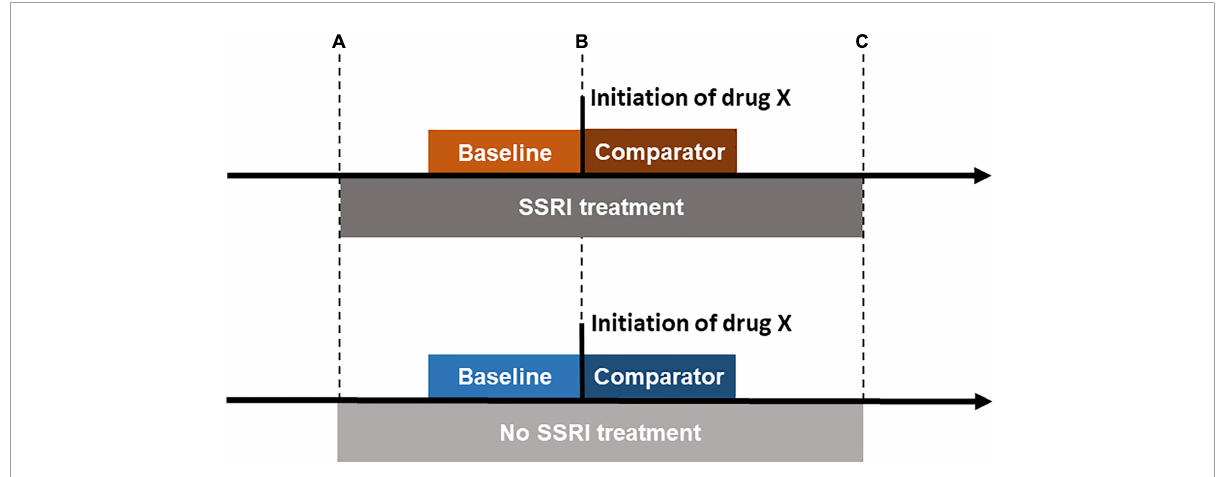
FIGURE1 Illustration of central nervous system (CNS) drug initiation during and outside of selective serotonin reuptake inhibitor (SSRI) treatment. The time period between points (A,B) and between (B,C) is required to be ≥ 30 days. For CNS drug initiations during SSRI treatment, the CNS drug initiation had to occur ≥ 30 days since the first SSRI prescription in the treatment period and at or before the last prescription in the continuous treatment period (the end of the treatment period is defined by adding 30 days to the date of the last prescription). For CNS drug initiations outside of SSRI treatment, the CNS drug initiation had to occur ≥ 30 days since the end of the last SSRI treatment period and at least 30 days before the first prescription in the next SSRI treatment period (if